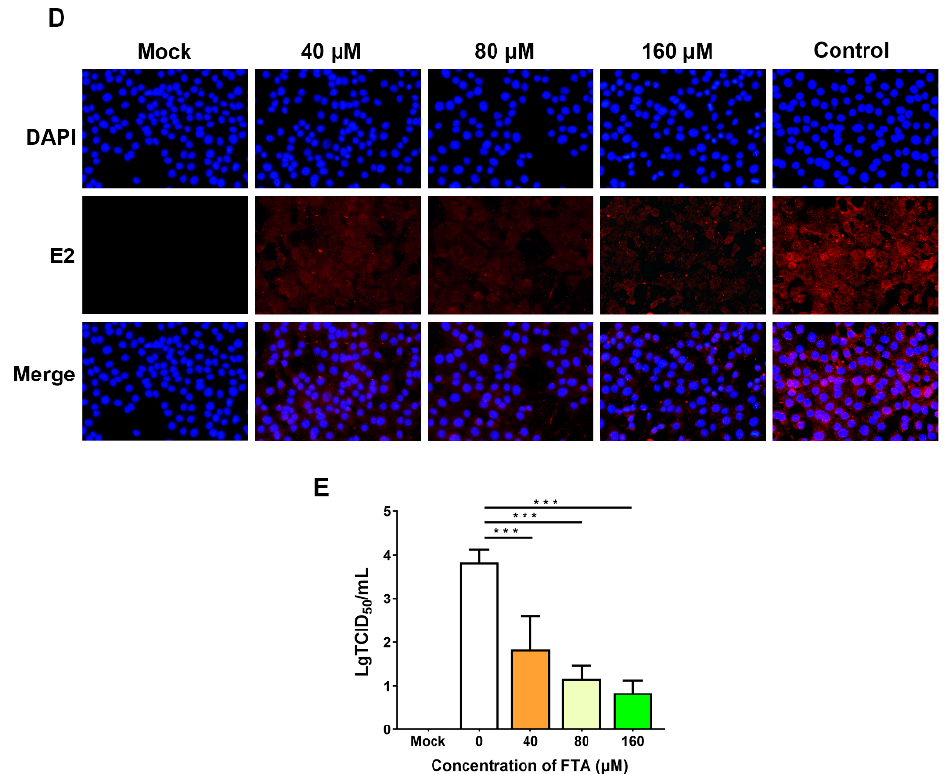
Figure 1. FTA directly inhibits BVDV proliferation in MDBK cells. ( A ) the cytotoxicity of the MDBK cells treated with various concentrations of FTA was determined by a CCK-8 assay. ( B ) 5 ′ UTR mRNA levels in BVDV infected cells treated with FTA were detected by RT-qPCR. ( C ) Lysates of BVDV infected cells treated with FTA were analyzed by immunoblotting. ( D ) IFA of BVDV-infected cells treated with FTA. The cells were fixed and stained with antibodies directed against BVDV E2 protein (red) and DAPI (blue). Scale bar, 50 μ m ( E ) The TCID 50 result for BVDV titers in BVDV infected MDBK cells treated with FTA. Data from three independent experiments and error bars are presented as the mean ± SEM. * p < 0.05, ** p < 0.01, *** p < 0.001.